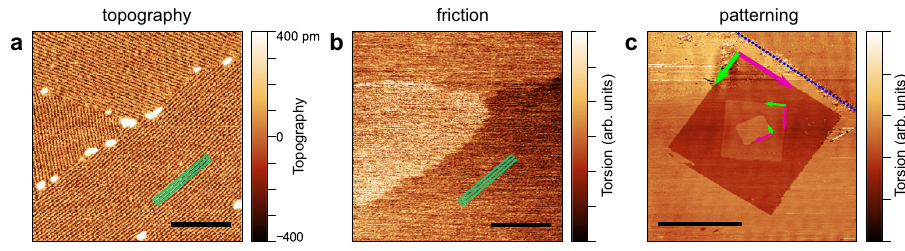
Fig. 4 | Self-assembled alkane layer as the source of friction domains. a PF topography image of a tripoint boundary of the stripes on graphene on hBN sample. b Contact mode torsion signal on the same area as ( a ), revealing three distinctfriction domains corresponding to the three differently oriented molecule domains. (Scale bars on a and b : 100nm). c Intentionally drawn nested, square-